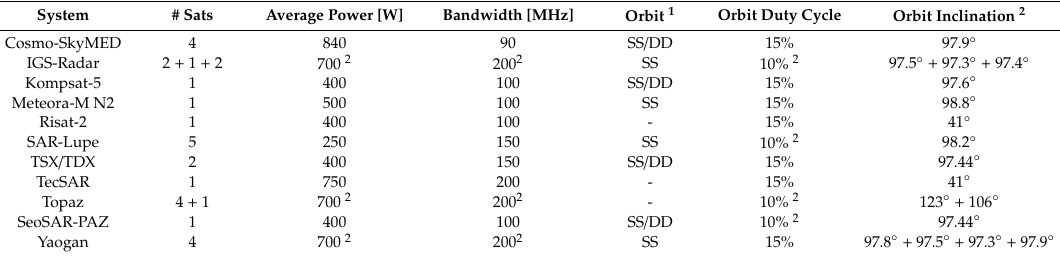
Table 1. Parameters of the 30 LEO-SAR satellites assumed in the